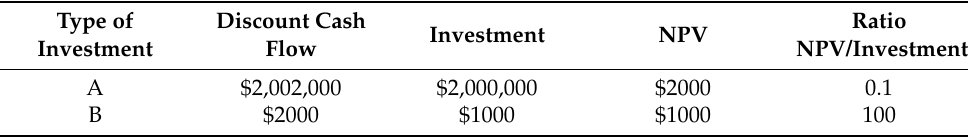
Table 2. Impact of initial investment on